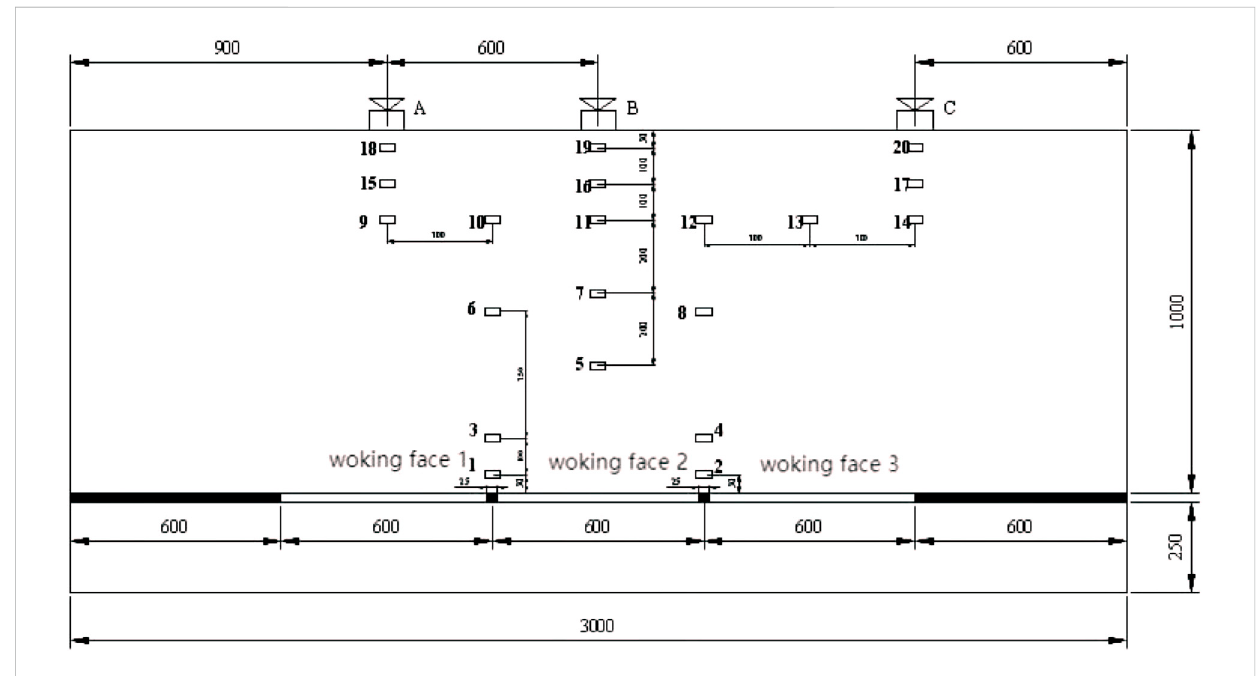
FIGURE 4 Location of earth pressure box (unit